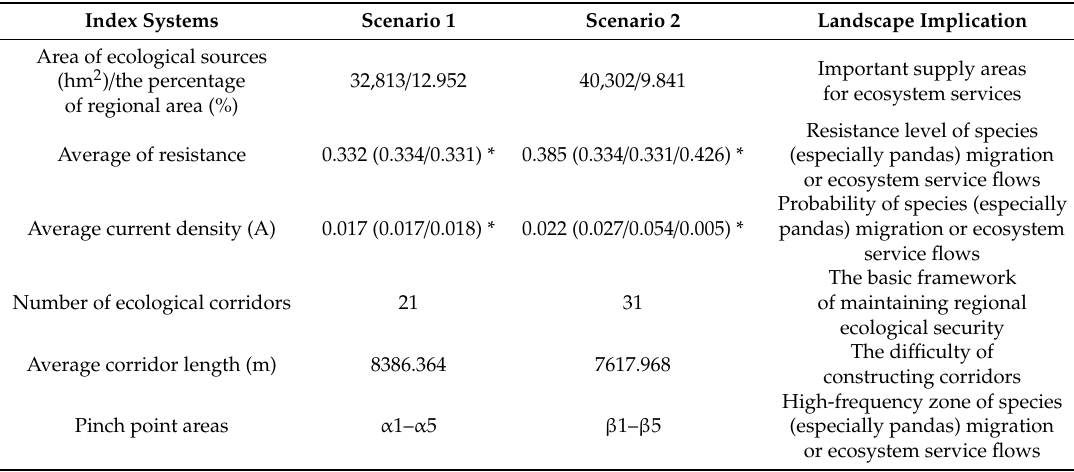
Table 5. ESP information statistics in two